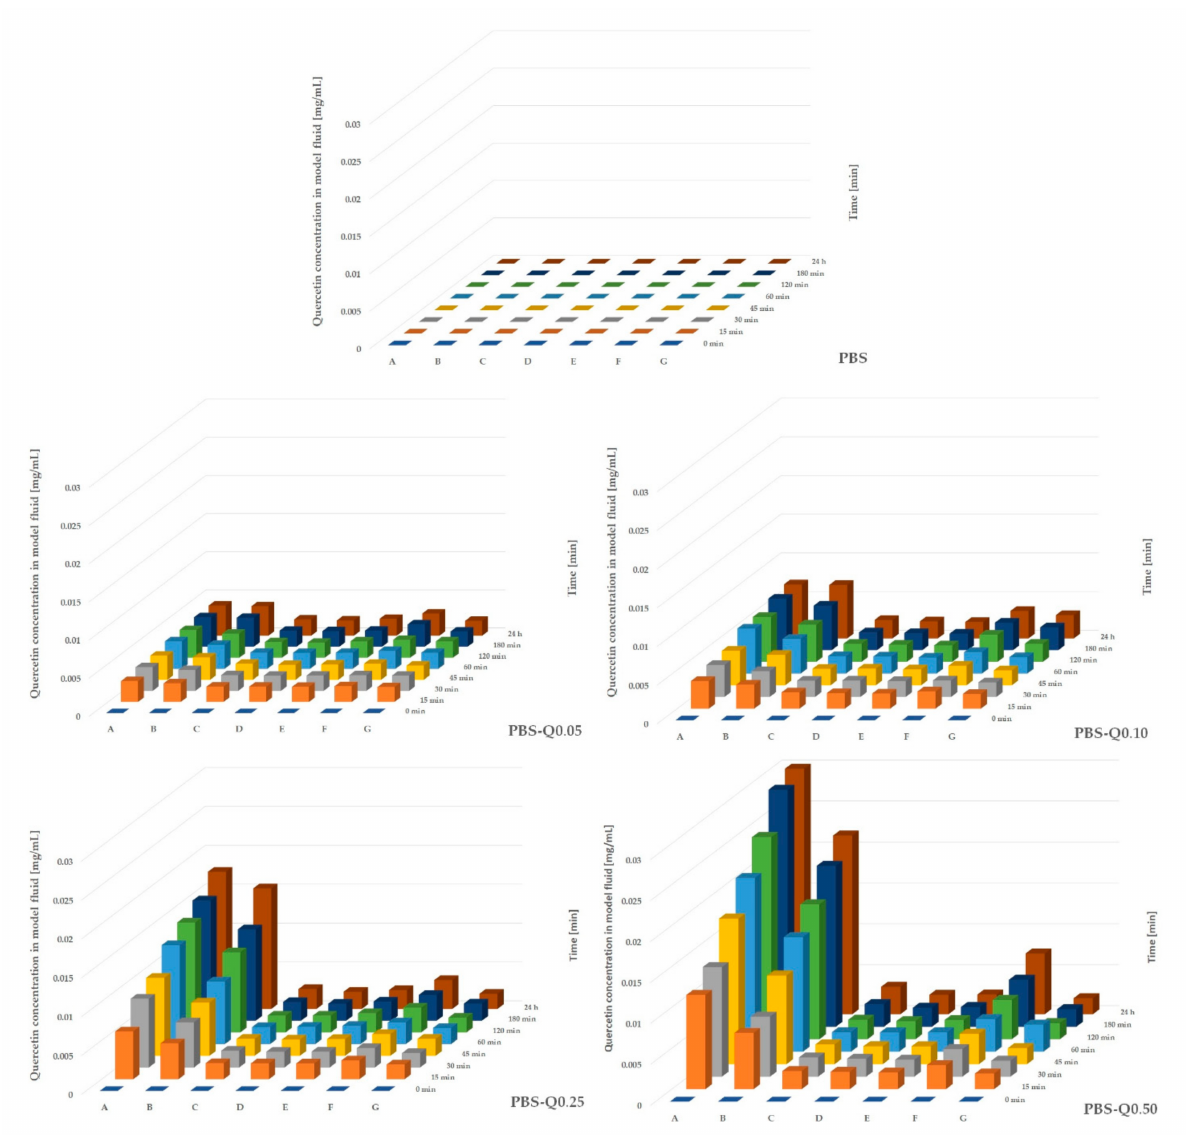
Figure 4. Migration of quercetin into model fluids: A—96% ethanol; B—50% ethanol; C—20% ethanol; D—10% ethanol; E—3% acetic acid; F—0.01M NaOH; G—distilled